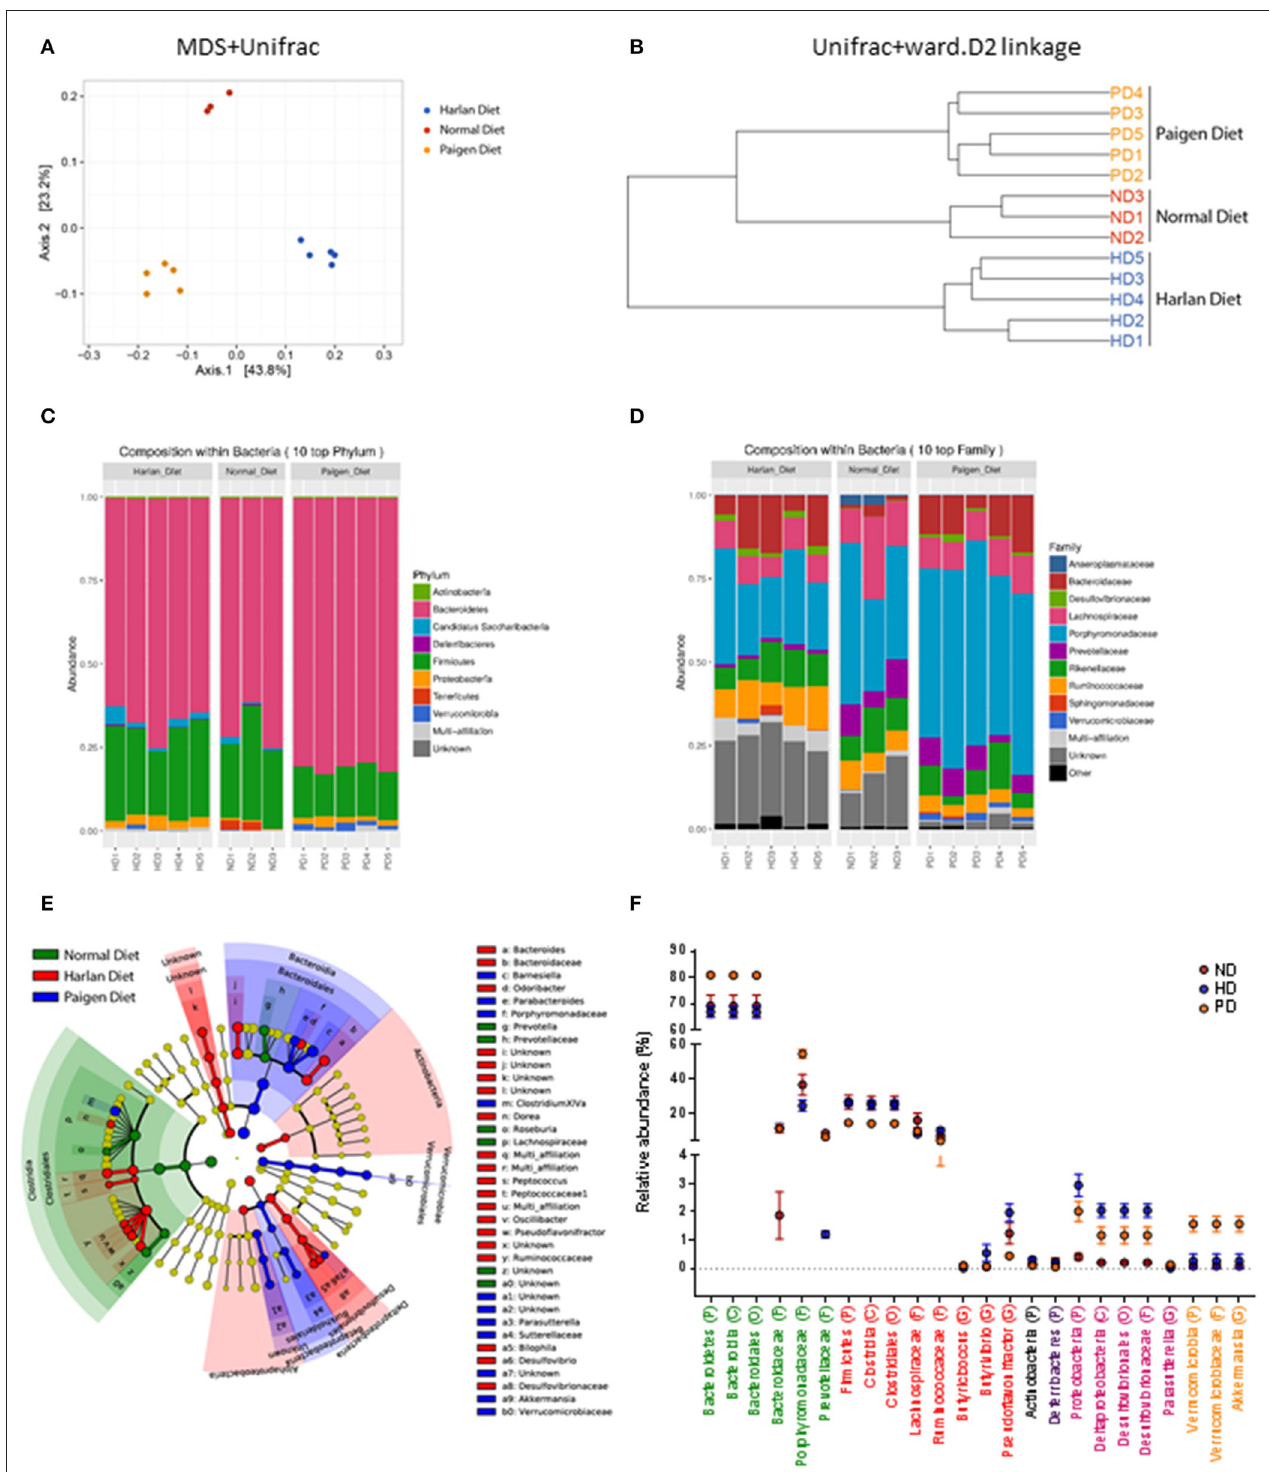
FIGURE 7 | Gut microbiota profiling in Normal diet (ND)-, High fat diet (HD)-, and Paigen diet (PD)-fed mice. (A) Multi Dimentional Scaling (MSD) of Unifrac distances of the fecal microbiota for each groups. (B) Hierarchical clustering of Unifrac distances of the fecal microbiota for each groups. (C,D) Relative abundance of Phylum and Family, respectively for each fecal sample. (E) Cladogram representing taxa enriched in fecal samples of ND, HD, or PD mice detected by the LEfSe tool. (F) Relative abundance of most significant taxa in fecal samples of ND, HD, or PD mice. Graphs are displayed as mean ± SEM.